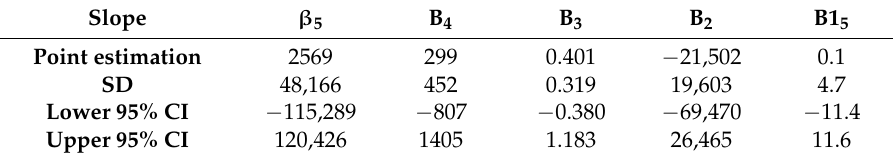
Table 2. Results calculated in the full model using linear